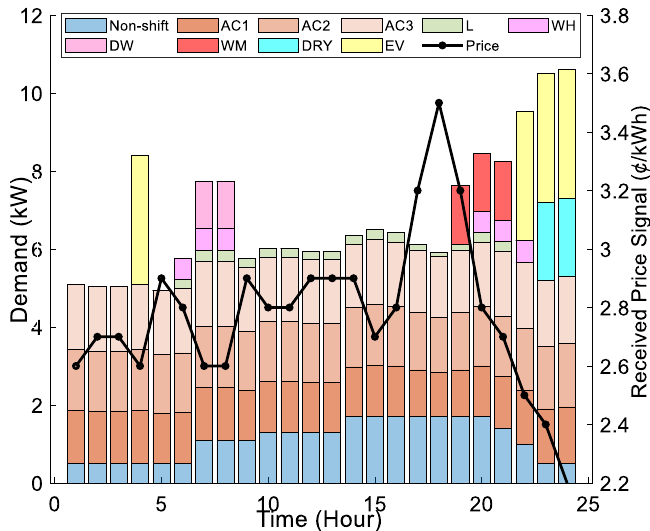
Figure 3. Aggregated energy consumption of all loads before DR (Base Case).